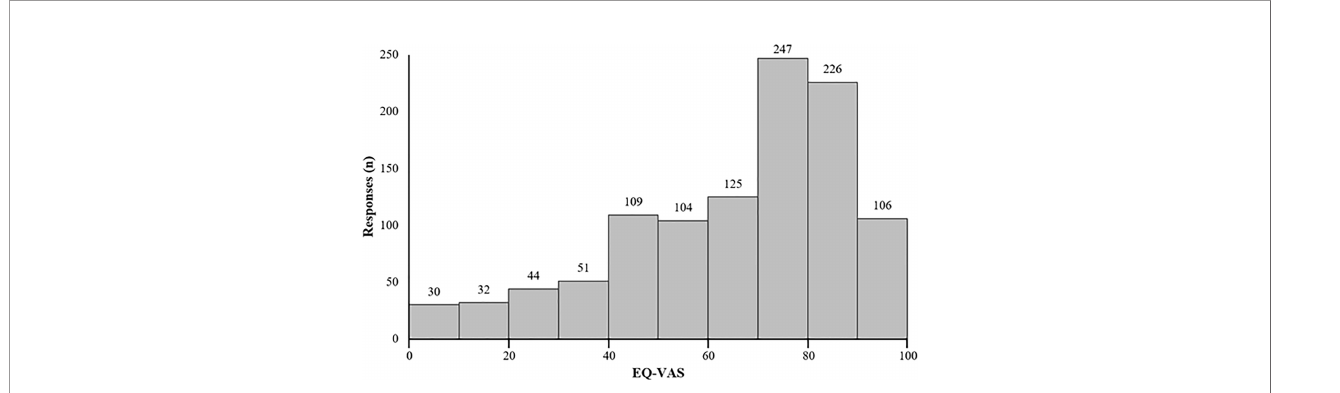
FIGURE 2 | Distribution of patient-reported EuroQol ’ s visual analogue scale (EQ-VAS) ( n = 1,074). Higher EQ-VAS values indicated improved self-rated health, and lower values indicated worse self-rated